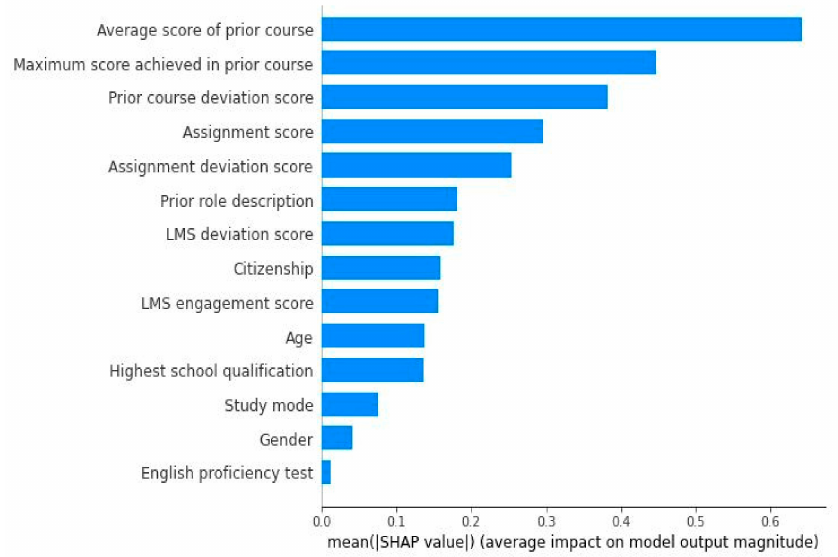
Figure 3. Feature importance